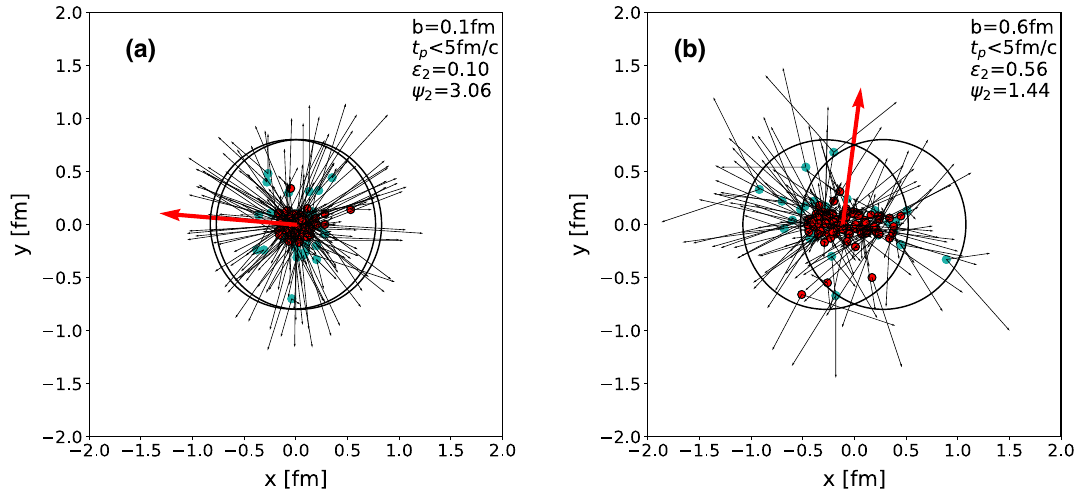
Fig. 12 Transverse view of the created parton system from the full AMPT in a central collision at b = 0 . 1 fm ( a ) and in a peripheral collision at b = 0 . 6 fm ( b ). Coordinates of the partons are represented by the dots. Initial parton velocity vectors are shown as black thin